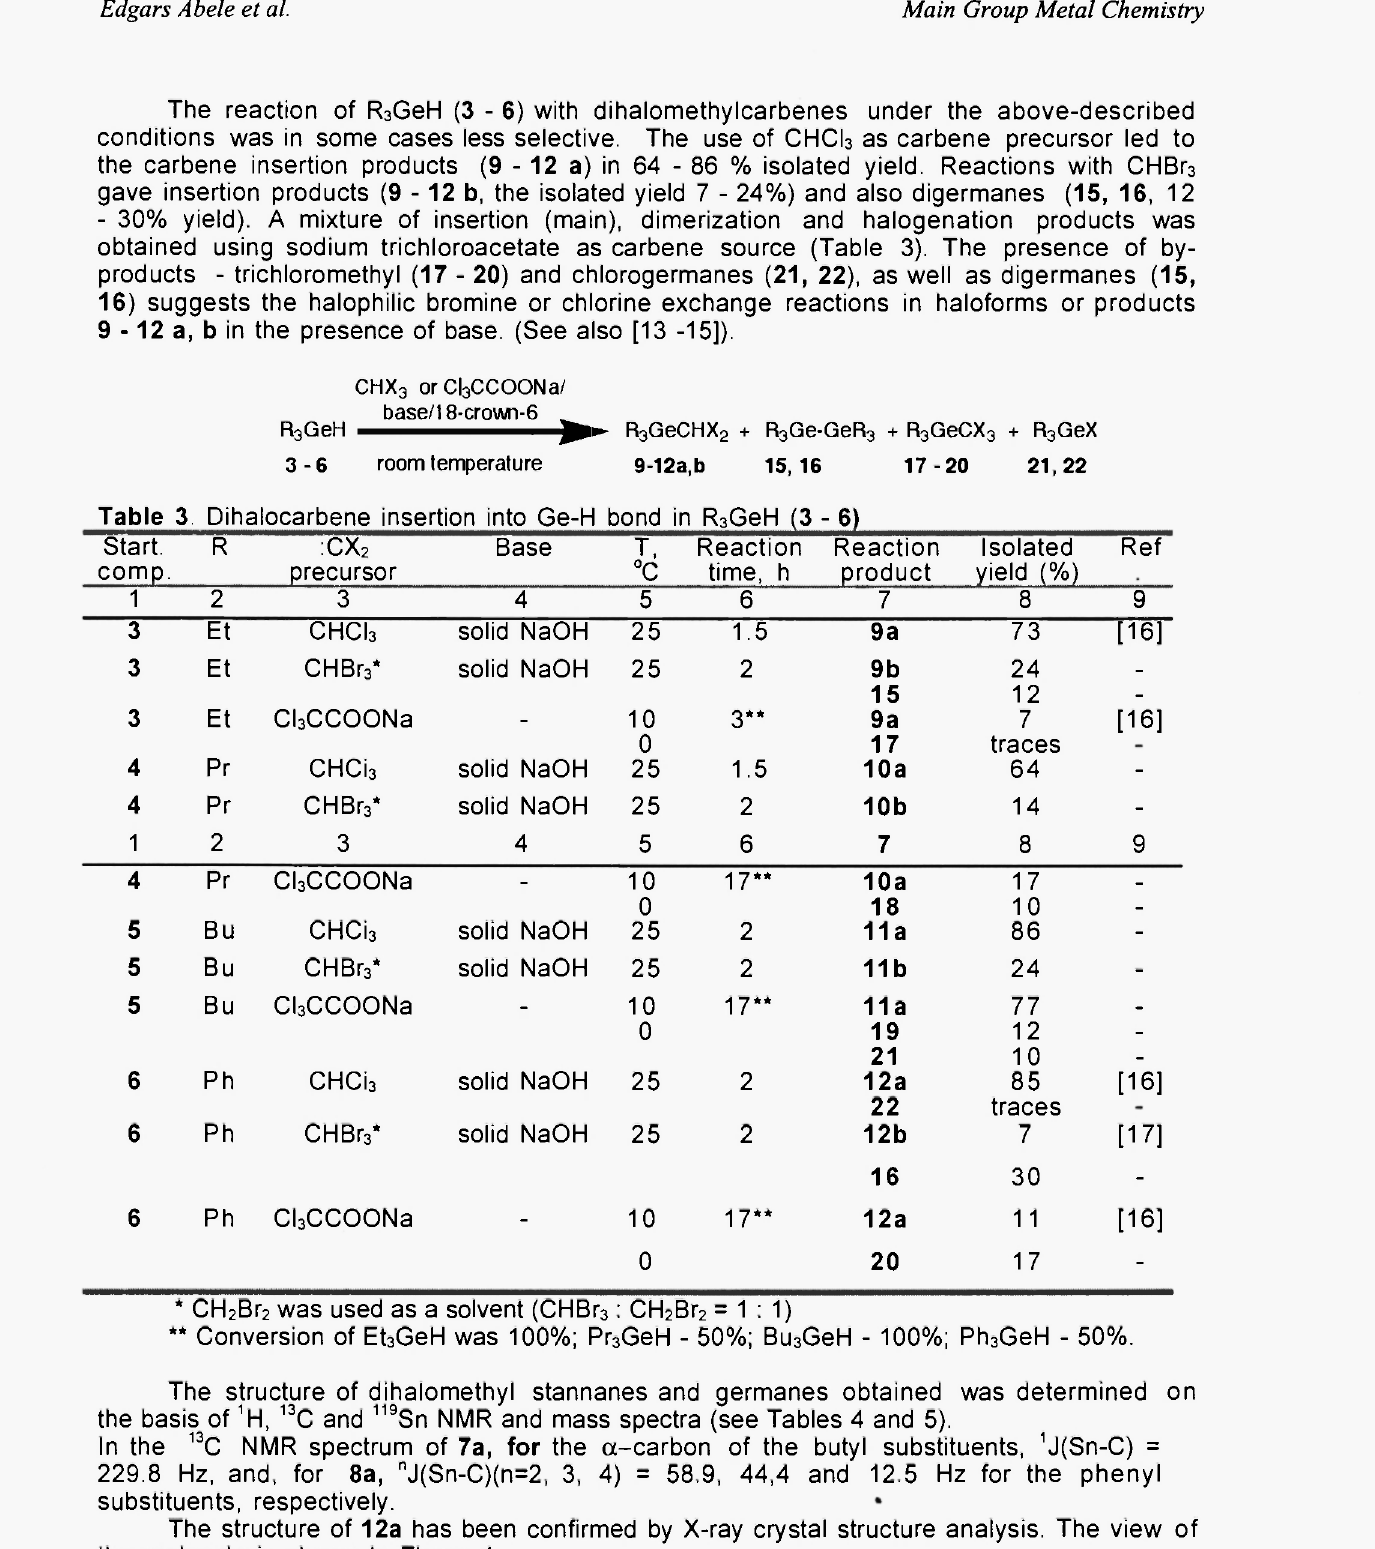
Table 8. In Fig 1 different orientations of disordered groups are shown in solid and dashed